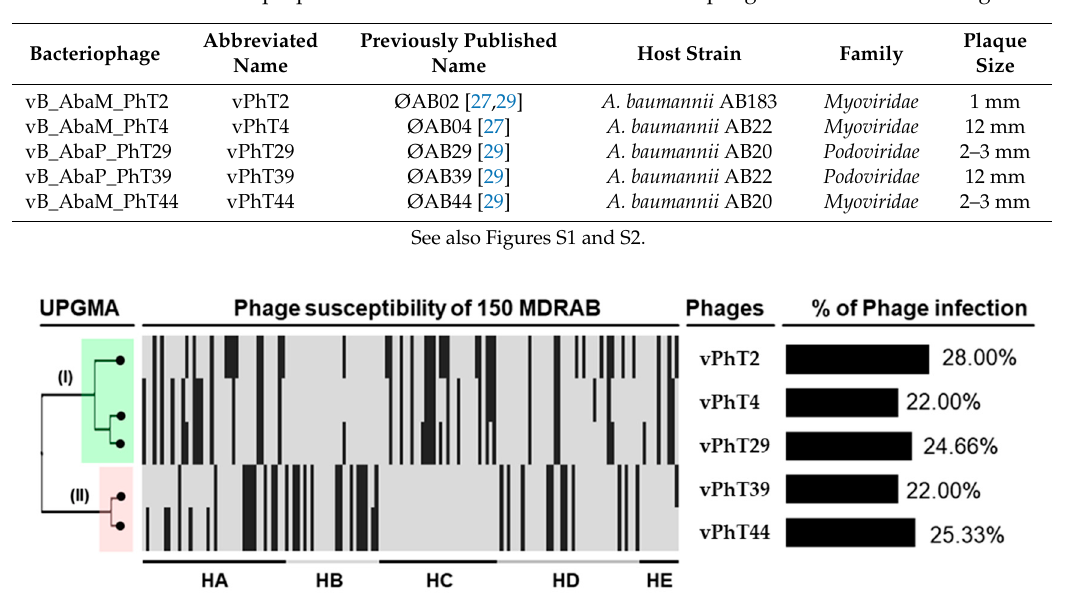
Table 1. Overview of properties of Acinetobacter baumannii bacteriophages with broad host ranges.